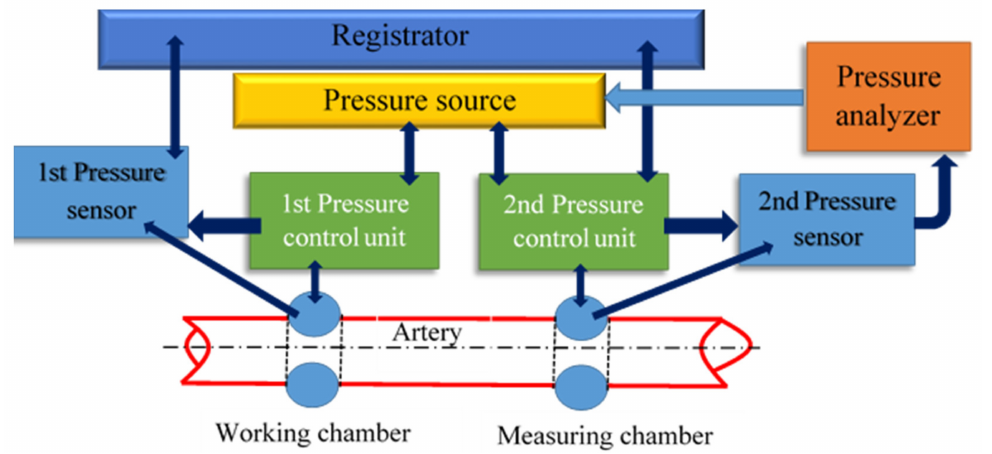
Figure 3. The block diagram of the «Hemodyn 1» device, for assessing the cardiovascular system state. It consists of a two-chamber compression hydraulic cuff, a pressure source (Pressure source), two pressure sensors (Pressure sensor), two pressure control units (Pressure control unit), a pressure analyzer (Pressure analyzer), and a registrar